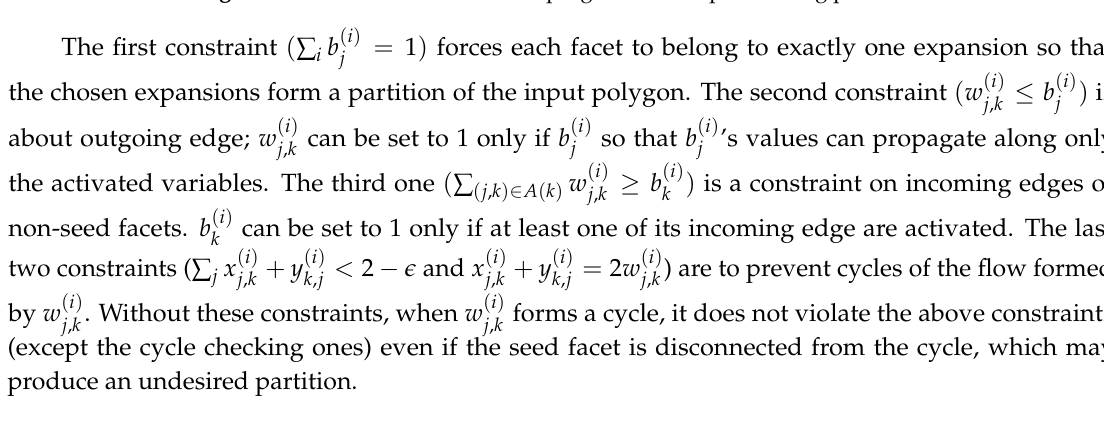
Figure 10. Illustration of the linear program for the partitioning